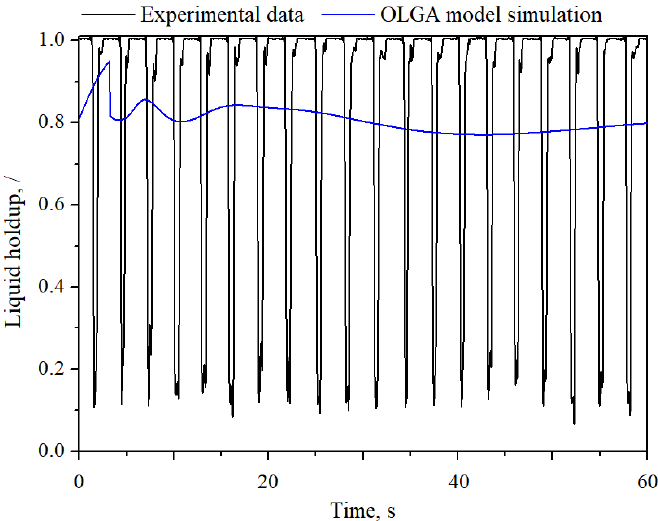
Figure 21. Experimental and simulated profile of liquid holdup in choking-induced bubbly flow ( U GS = 0.08 m/s and U LS = 0.09 m/s).